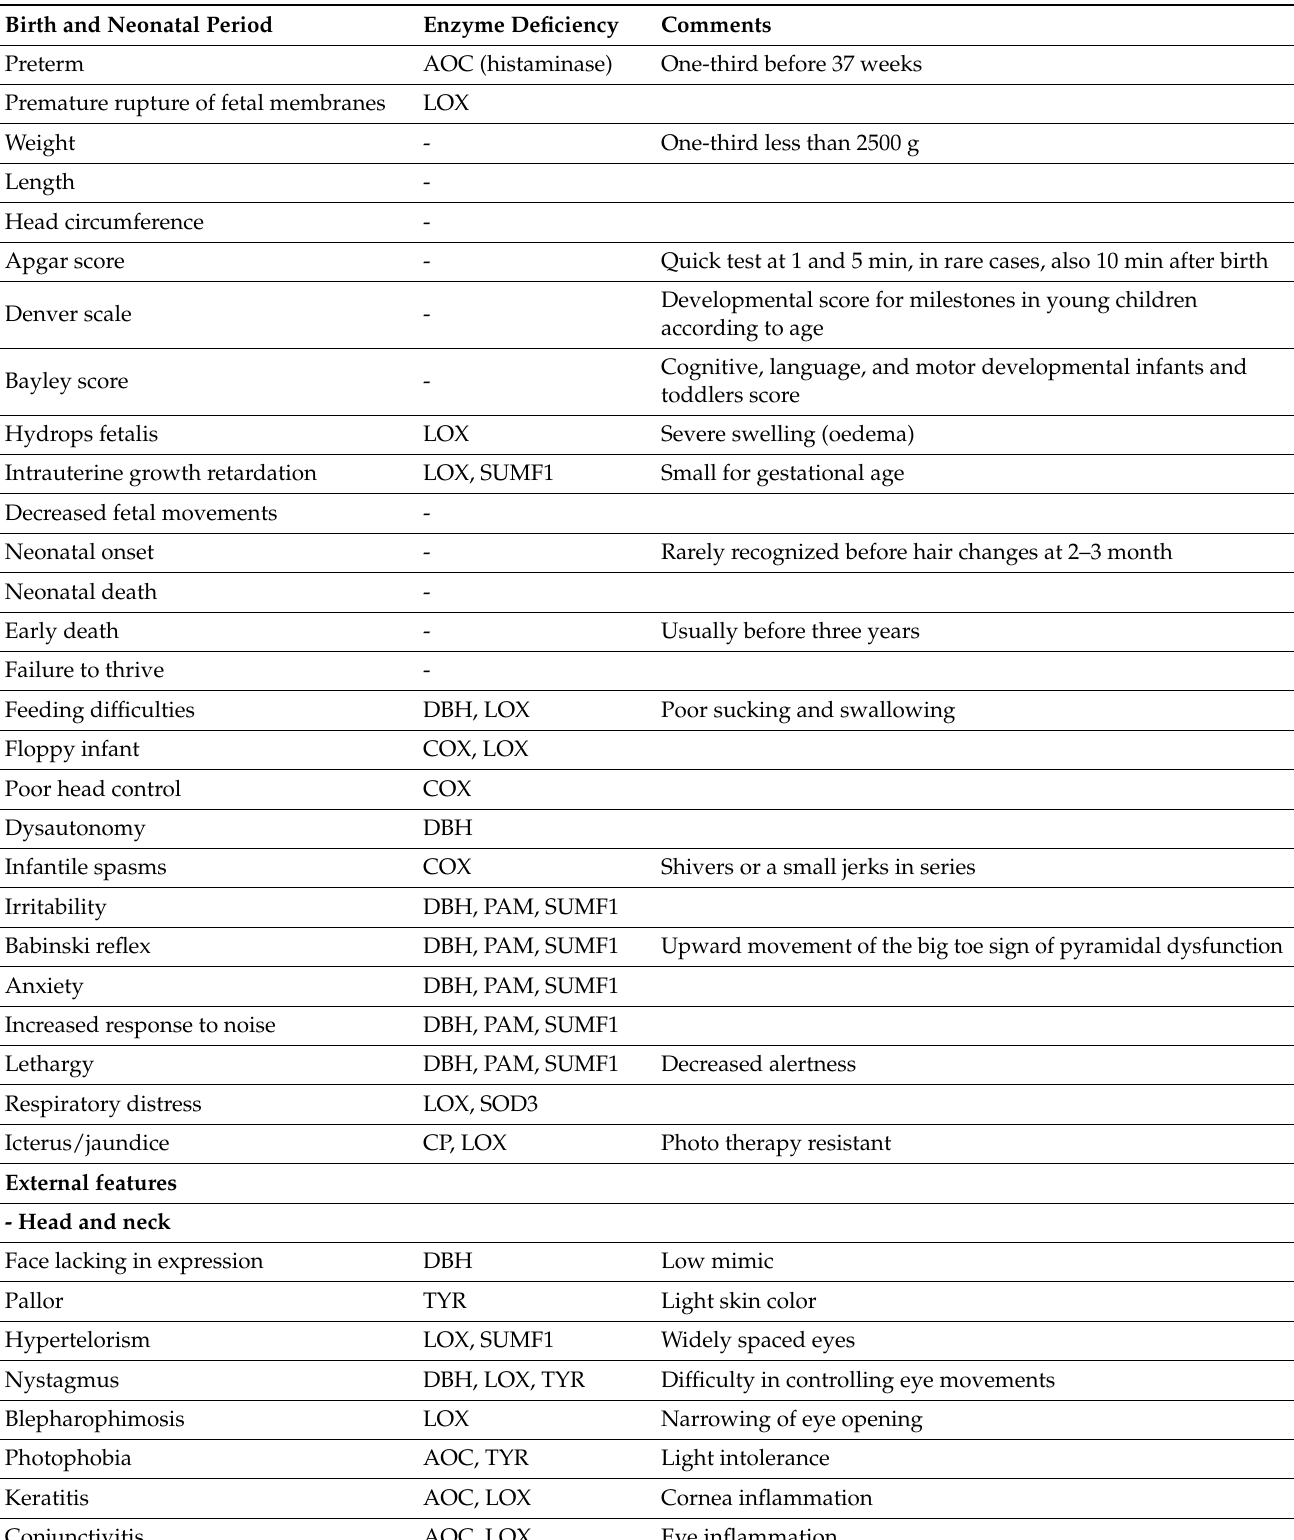
Table 3. Menkes Disease